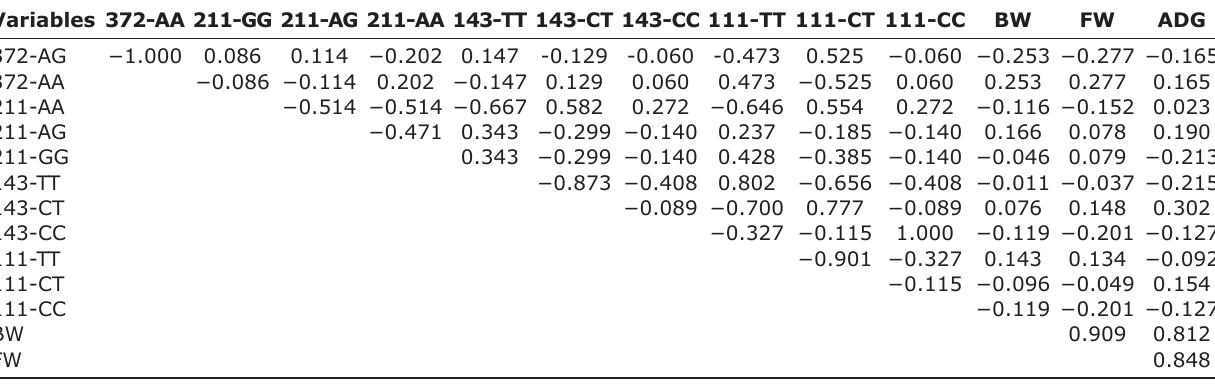
Table-4: Correlation matrix between the genotypes identified on FABP4 gene and performance traits studied.